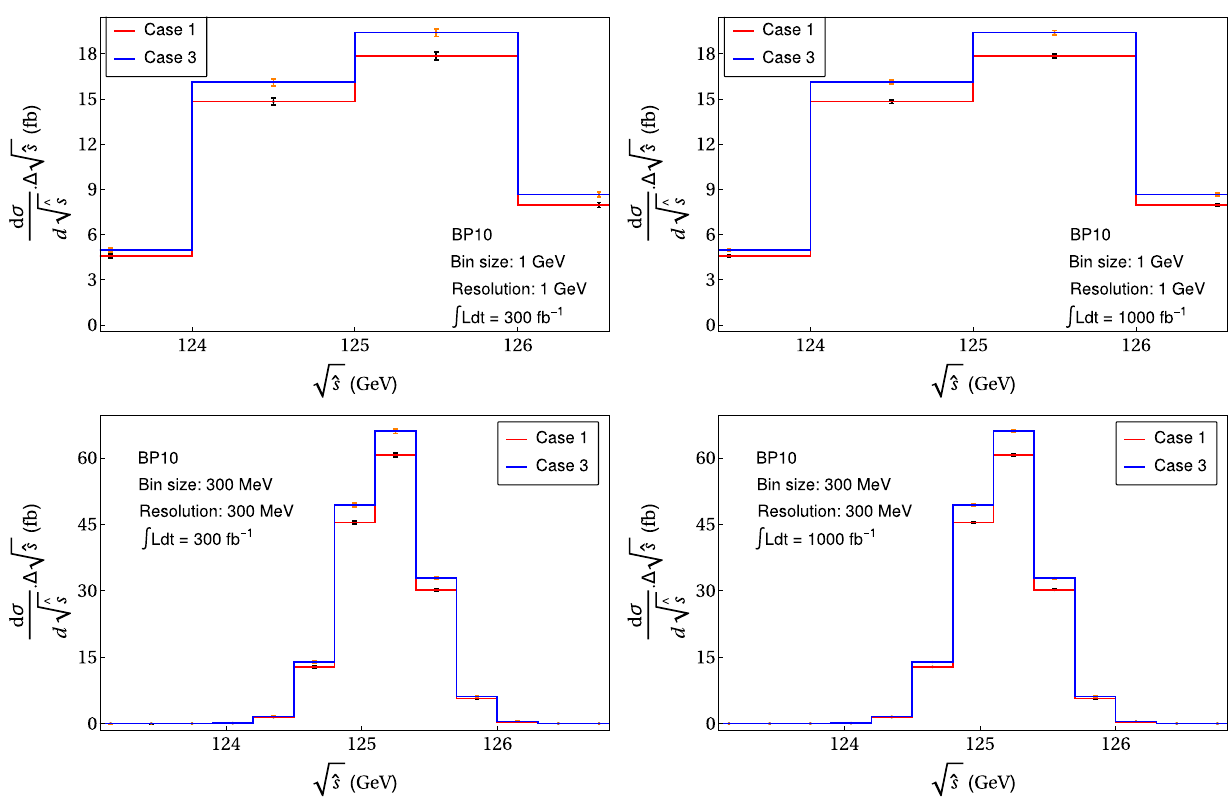
Fig. 6 Convolution of the distributions 1 and 3 for BP10 with Gaussians of width 1GeV ( top ) and 300MeV ( bottom ). An integrated luminosity of 300fb − 1 is assumed in the left panels and of 1000fb − 1 in the right